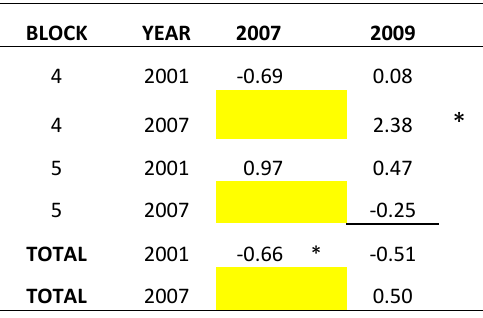
Table 4. Comparison of perception bias corrected abundance estimates of humpback whales for selected strata and the entire survey area. Estimates for 2001 are from Pike et al. (2009). Only strata where significant ( P <0.05) changes to or from non-zero values occurred are shown. Cells list proportional change from first year to second. * = P <0.05.